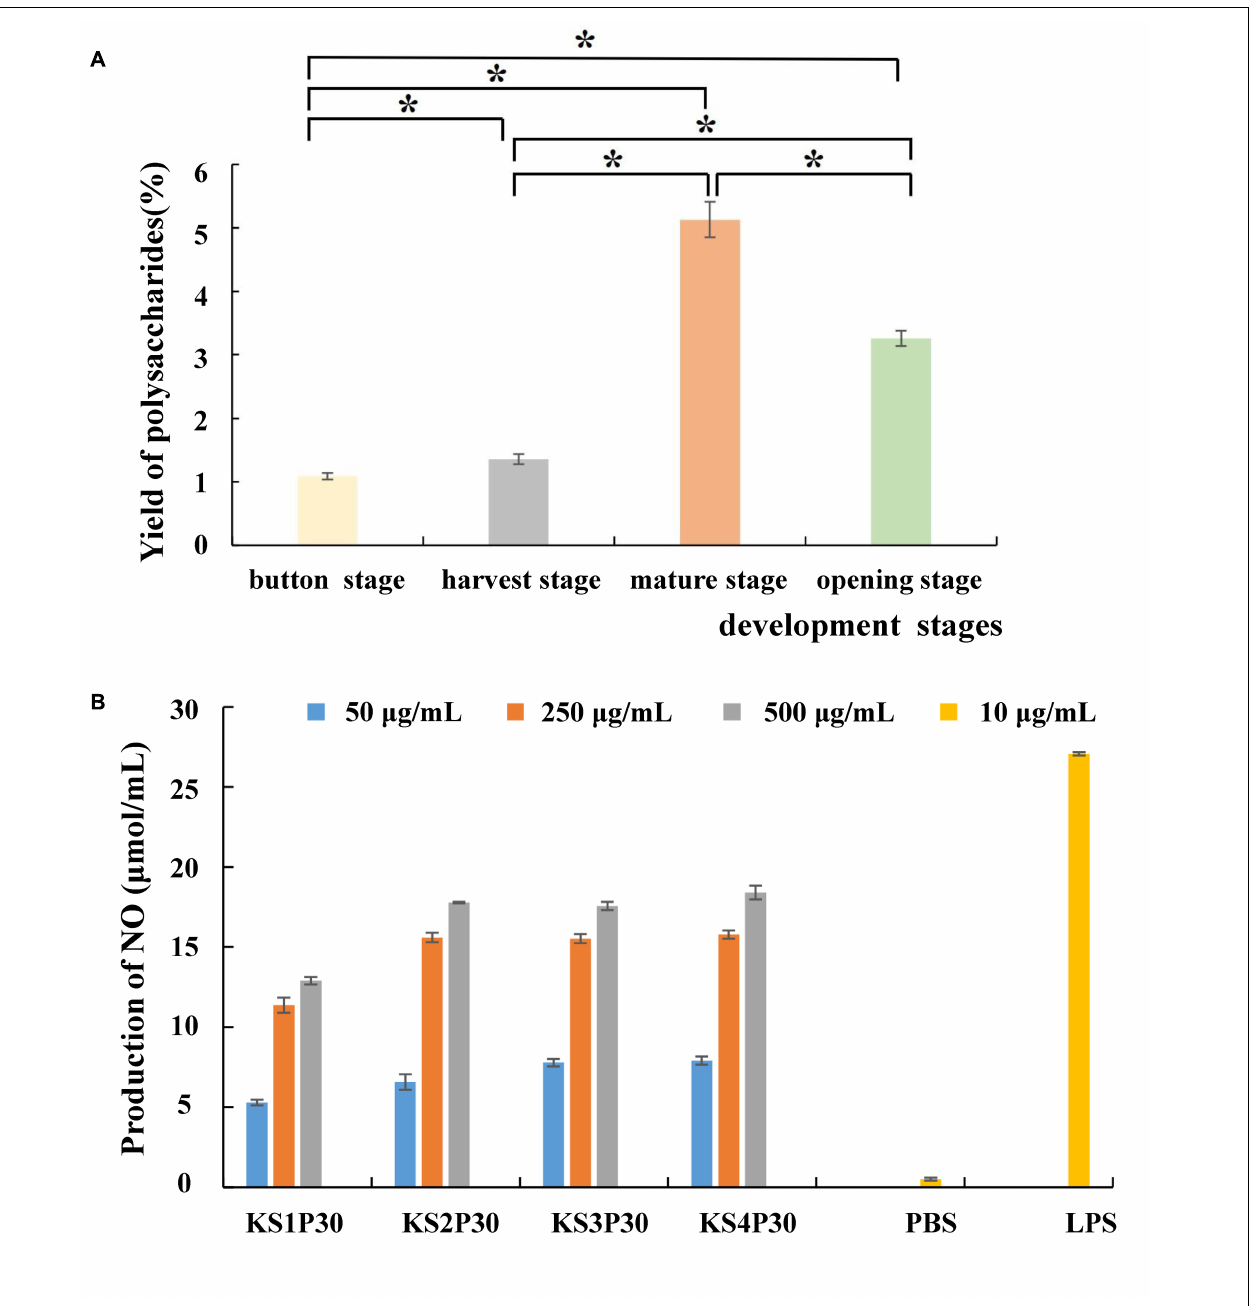
FIGURE 3 | Yield and macrophage activation of LEFP30 obtained from different development stages. (A) Yields of polysaccharides. *Means that polysaccharide yield between the two was significantly different ( p < 0.05). (B) Effect of polysaccharides obtained from different development stages on nitric oxide (NO) synthesis in murine macrophage-like cells RAW264.7 cells (5 × 10 5